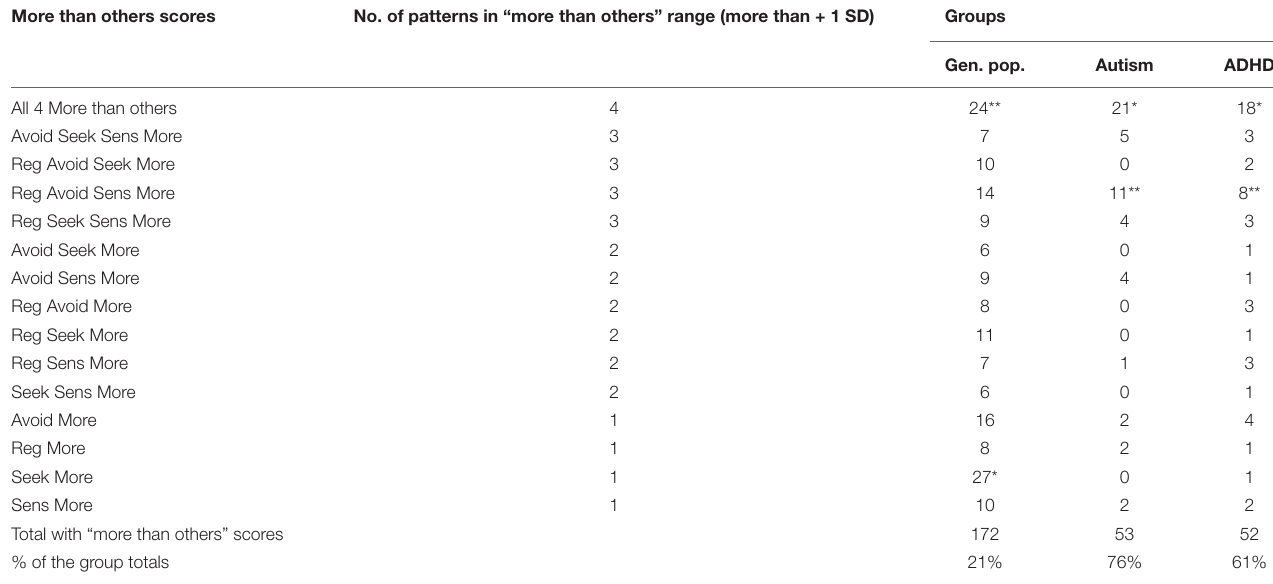
TABLE 2 | Number of children who had some pattern of “more than others” scores. More than others